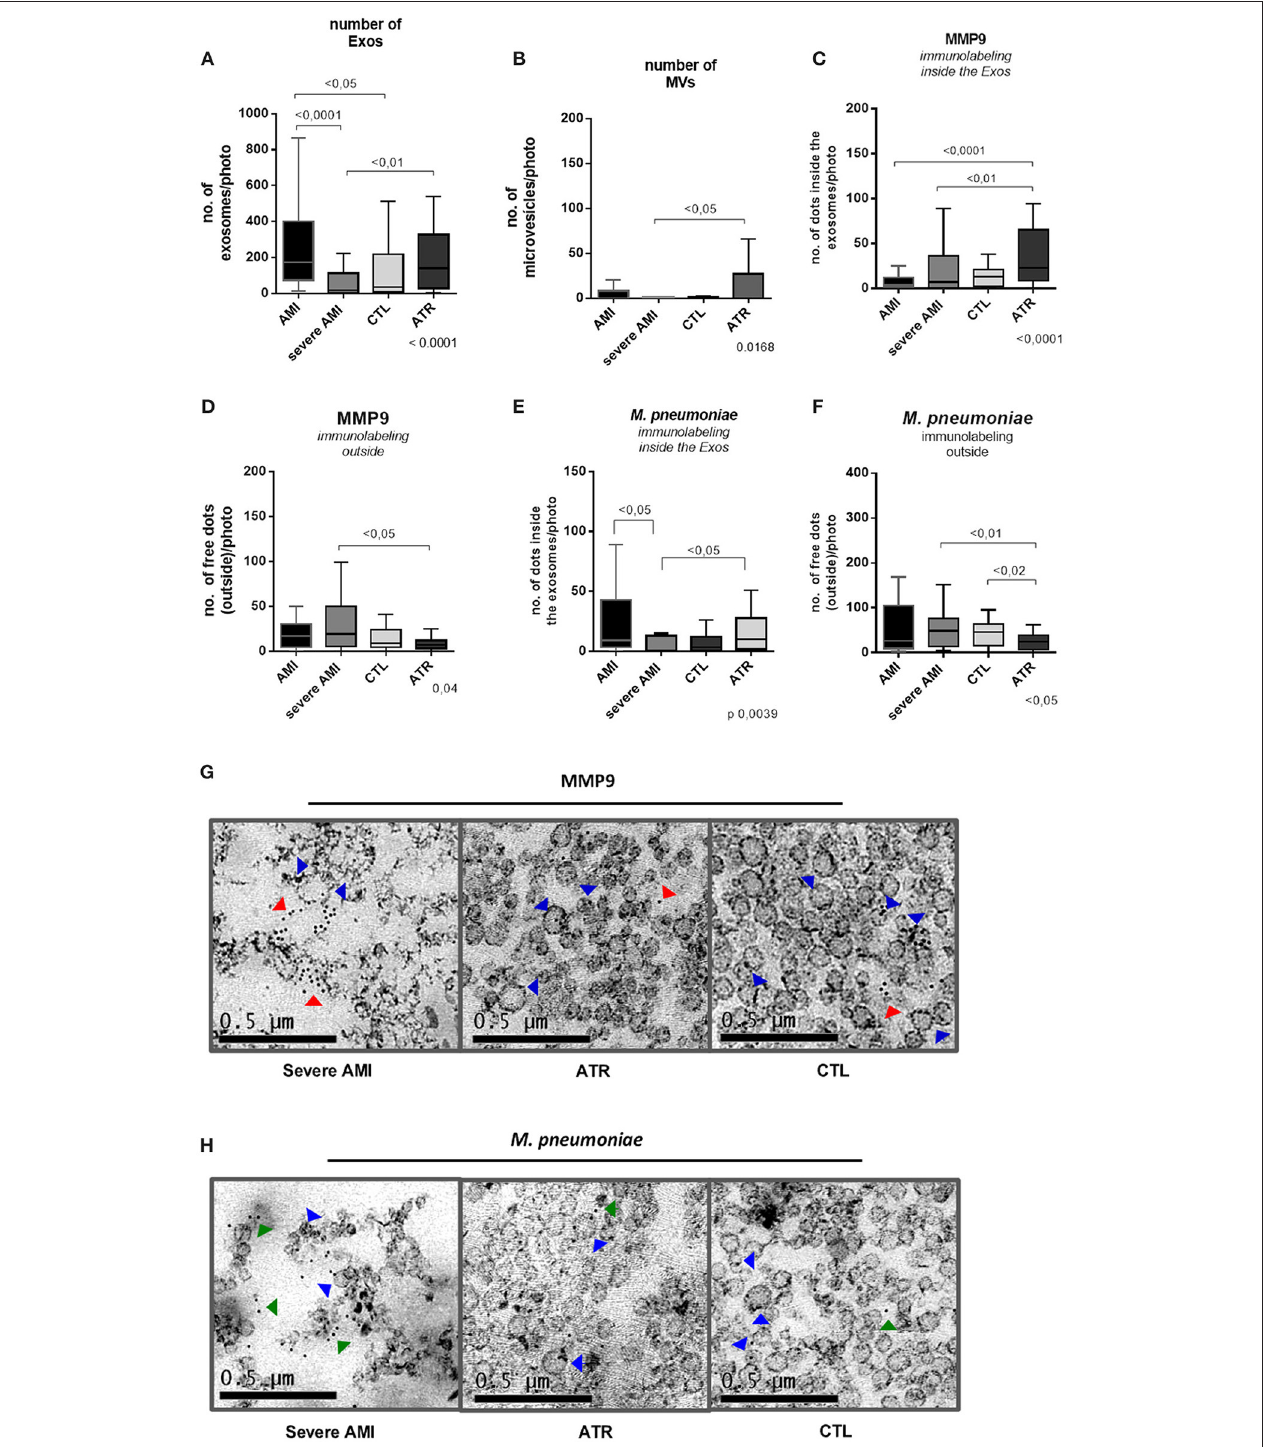
FIGURE 2 | Immunolabeling for MMP9 and M. pneumoniae by transmission electron microscopy. The decrease in exosomes leads to poor removal of MMP9 and M. pneumoniae antigens in severe infarction. (A) Number of exosomes/photos. (B) Number of microvesicles/photo ( n = 10. per group). (C) Number of MMP9 antigens (dots) inside exosomes/photo ( n = 10. per group). (D) Number of MMP9 antigens (dots) outside exosomes/photo ( n = 10. per group). (E) Number of M. pneumoniae antigens (dots) inside exosomes/photo ( n = 10. per group). (F) Number of M. pneumoniae antigens (dots) outside exosomes/photo ( n = 10. per group). (G,H) Severe AMI has a greater number of free antigens (red arrow, MMP9; green arrow, M. pneumoniae ), and ATR has greater numbers of MMP9 and M. pneumoniae antigens within the EVs (blue arrow). Immunogold 10 nm − 50,000X.